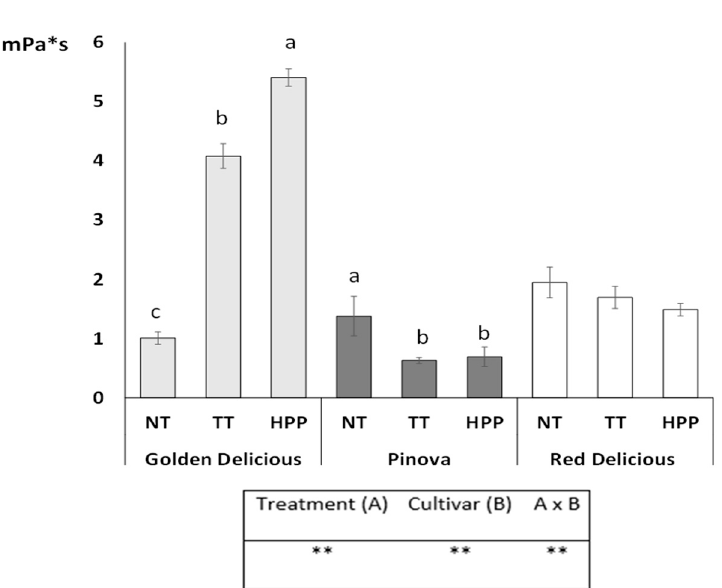
Figure 1. Viscosity values determined in apple juice samples. The means with different letters are significantly different ( p < 0.05); stars indicate variable influence and strong interaction among considered factors.